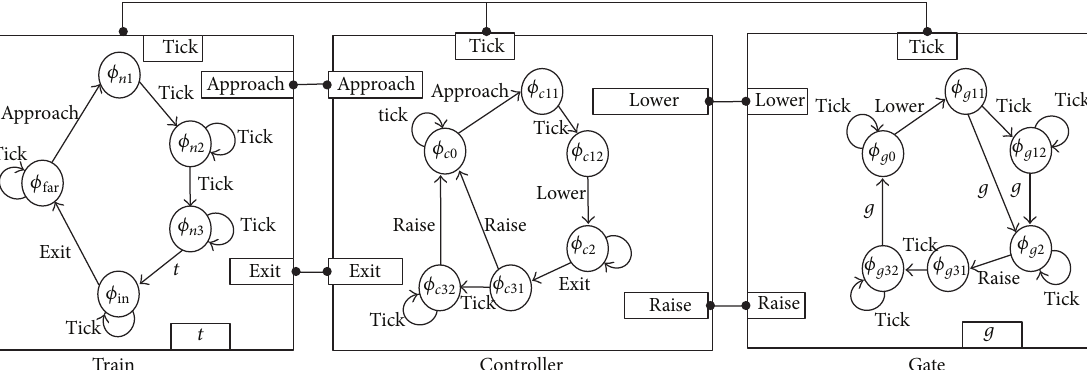
Figure 3: The abstraction for the TGC.